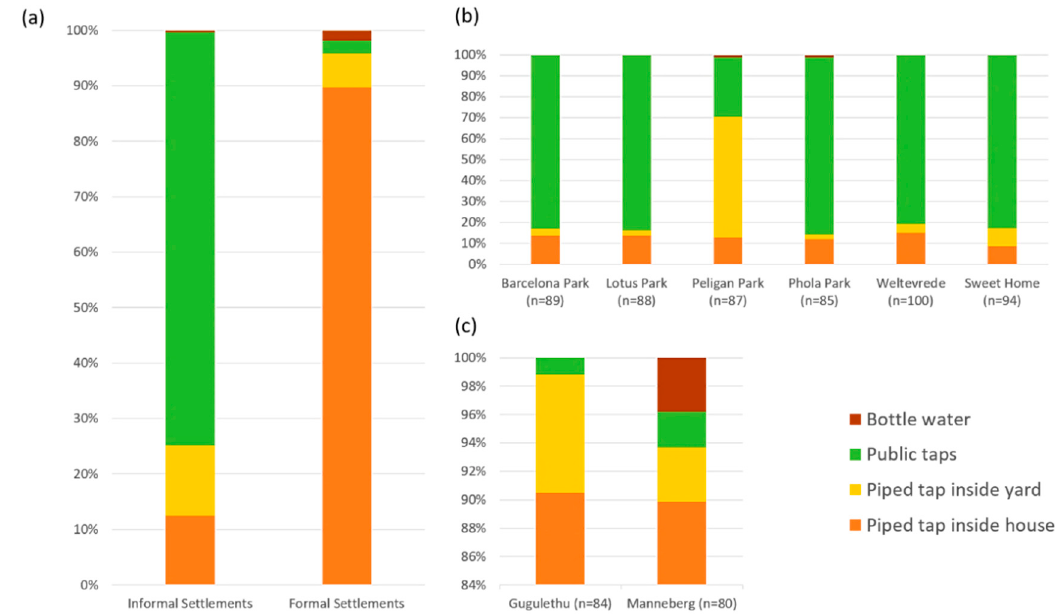
Figure 2. Types of drinking water sources ( a ) in each settlement type; ( b ) in six informal settlements ( c ) in two formal settlements.